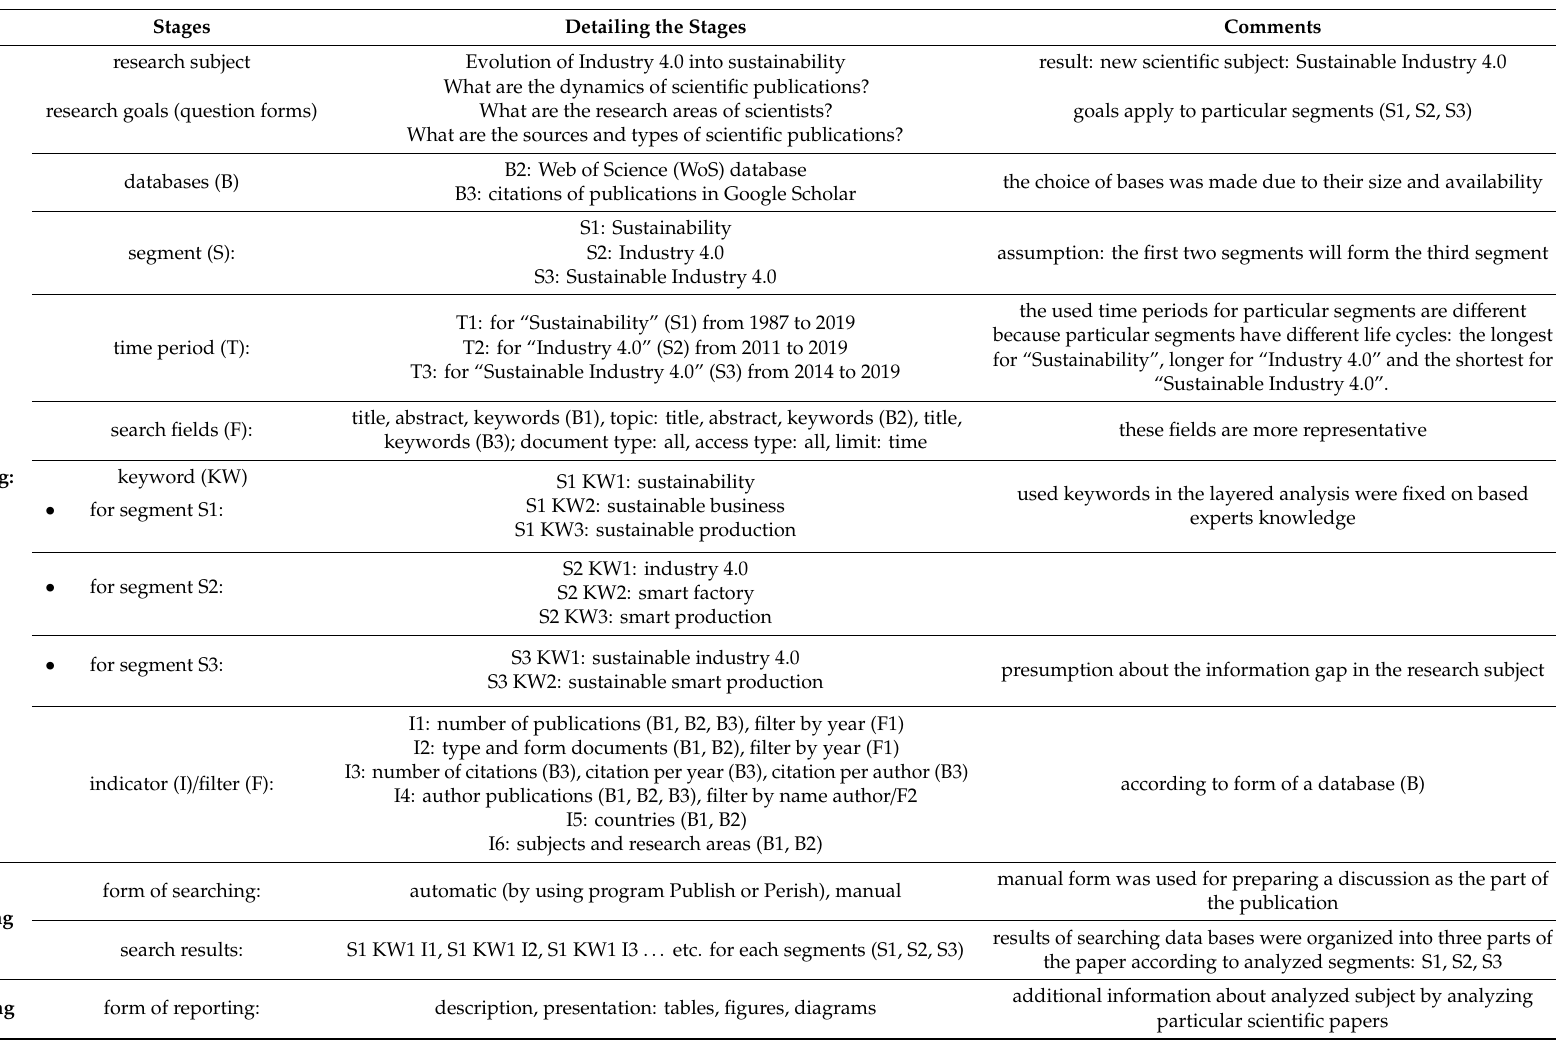
Table 1. Steps of bibliometric analysis in the subject: “Sustainable Industry